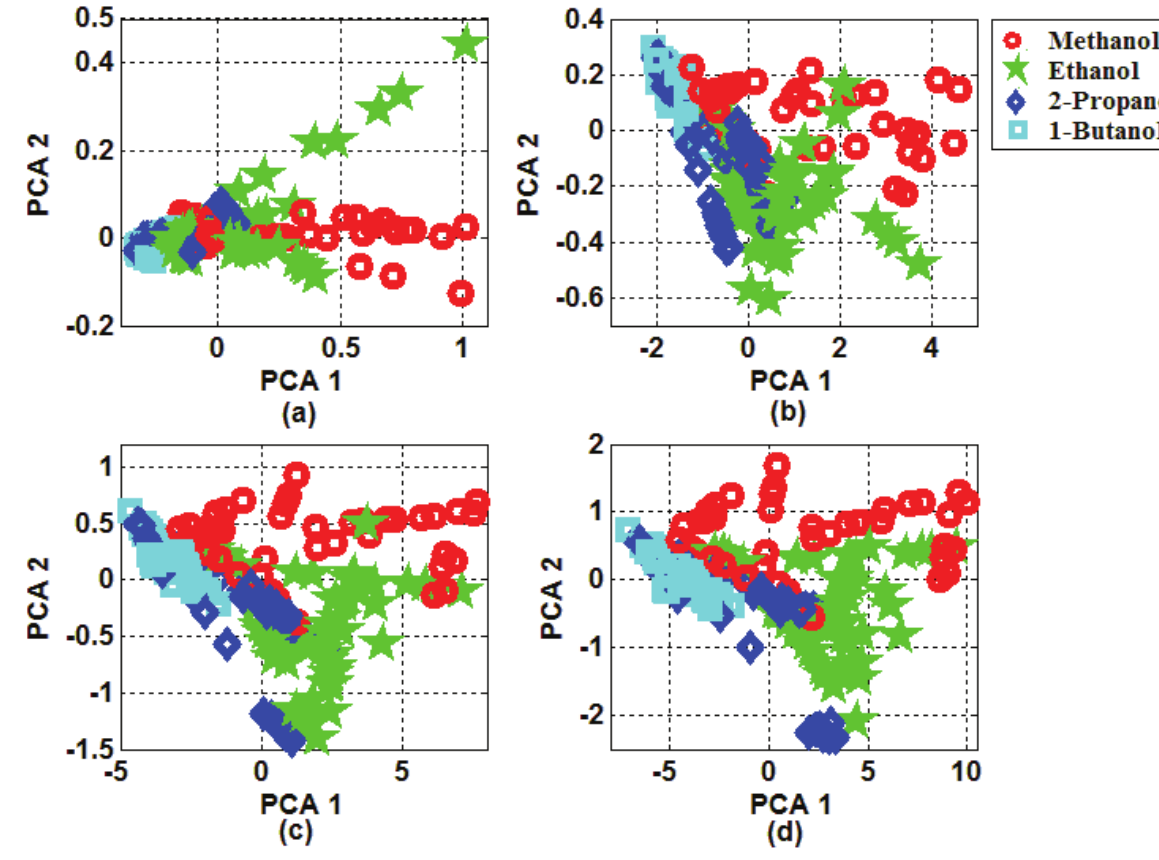
Figure 5. (a) PCA Projection results of the first 25 samples selected portions of transient response. (b) The same for the first 50 samples. (c) The same for the first 75 samples. (d) The same for the first 100